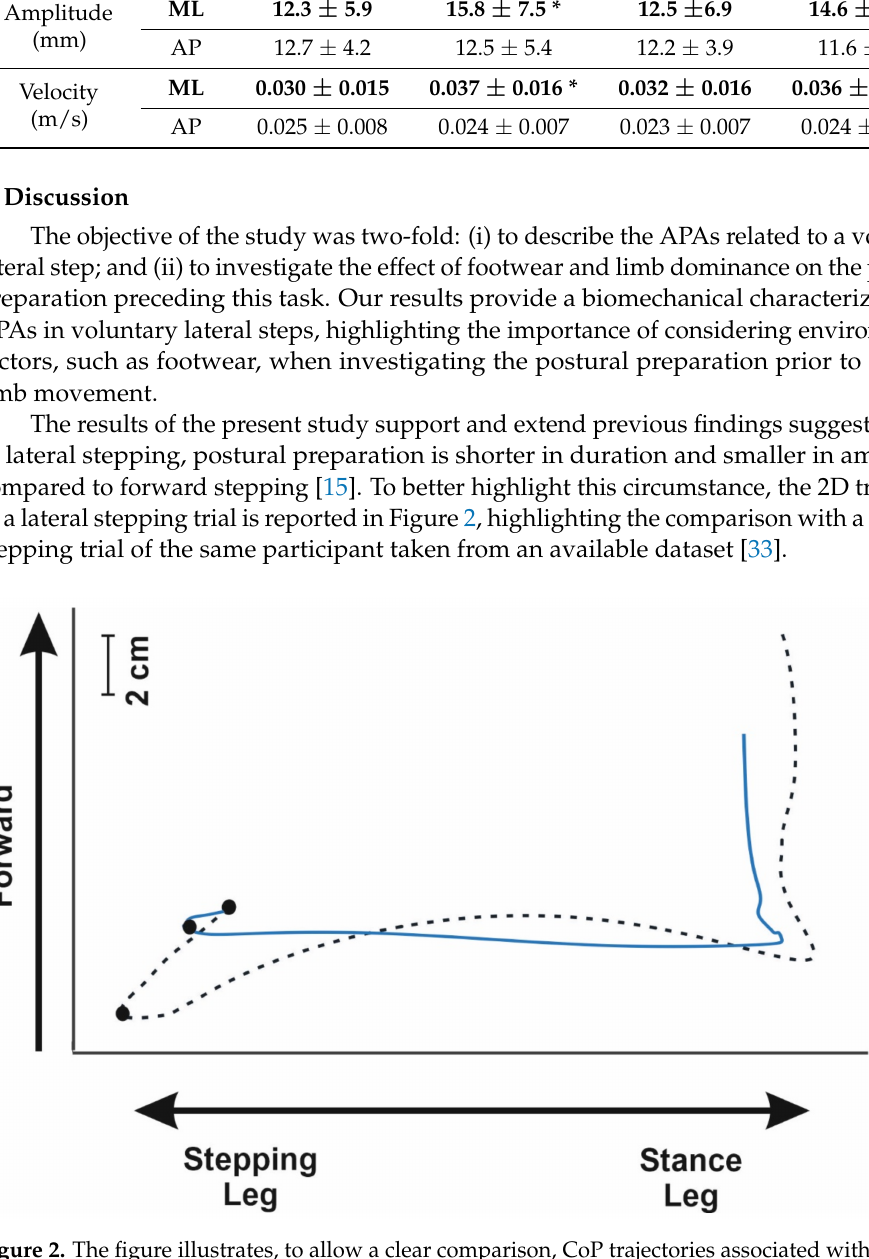
Figure 2. The figure illustrates, to allow a clear comparison, CoP trajectories associated with postural preparation prior to a lateral step (light blue line) and a forward step (black broken line) in the same participant; data of the forward step initiation was collected, analyzed and published as part of another study [33]. The trials were performed in barefoot condition. The black dots highlight the start and end of APAs for the two